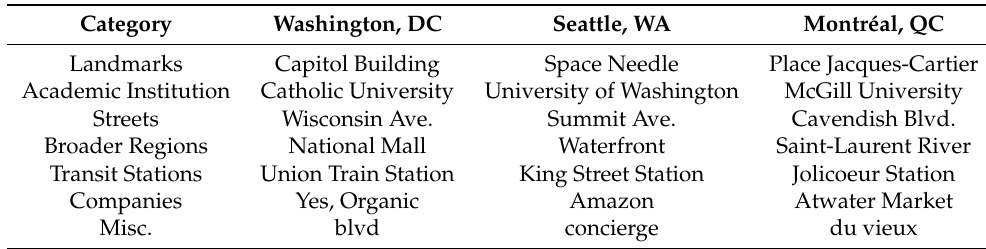
Table 7. Examples of n-grams falsely identified as neighborhood names split by city (columns) and category